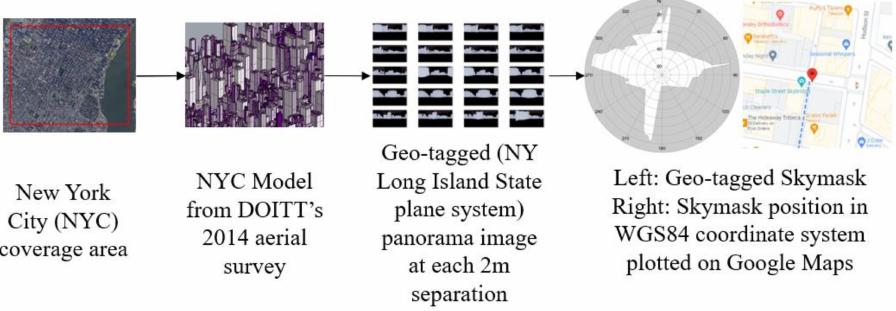
Figure 2. Geo-tagged skymask generation from NYC 3D